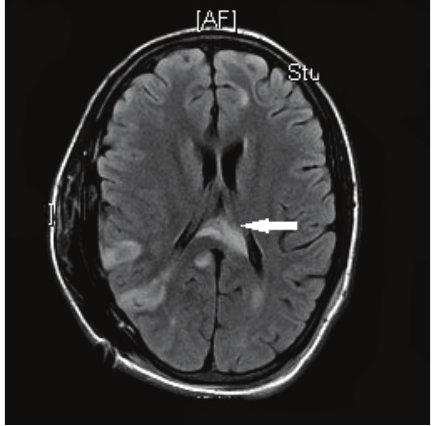
Figure 5: Postop MR demonstrating infarcts from herniation including the left cerebral crus infarcts (white arrow) and right parietal